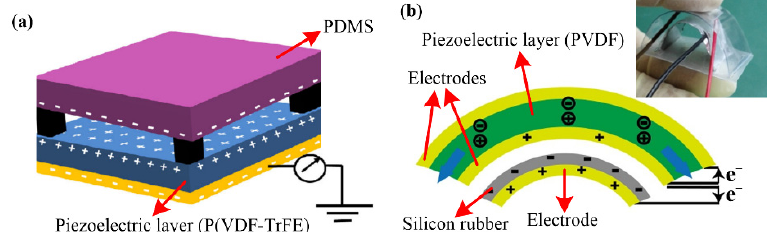
Figure 6. Structures of triboelectric-piezoelectric hybrid generators: ( a ) A pressure sensor with a self-poled P(VDF-TrFE) sponge acting as the tribo-layer (Reproduced with permission [25]. Copyright 2017 Tsinghua University Press and Springer-Verlag GmbH Germany); ( b ) A vibration sensor with a double-arched structure (Reproduced with permission [57]. Copyright 2017 Elsevier).